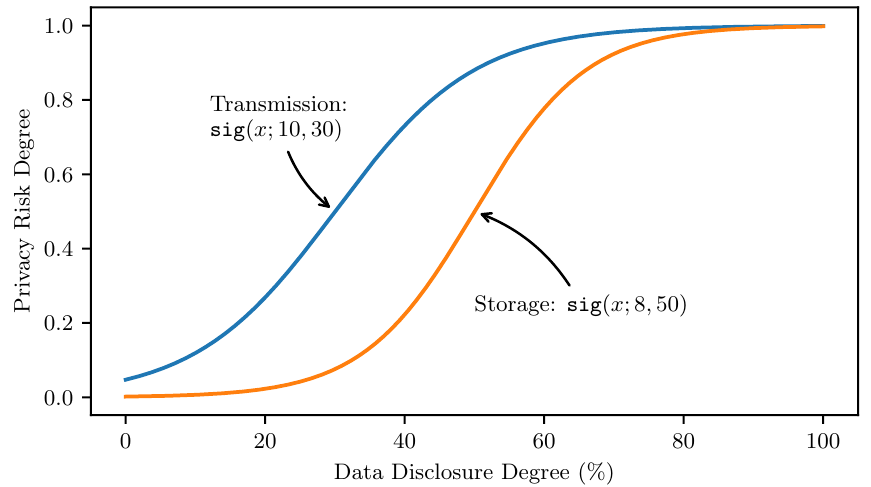
Figure 1. Two potential fuzzy membership functions for estimating and measuring privacy risks in different data contexts. (See their explanation and usage in Section